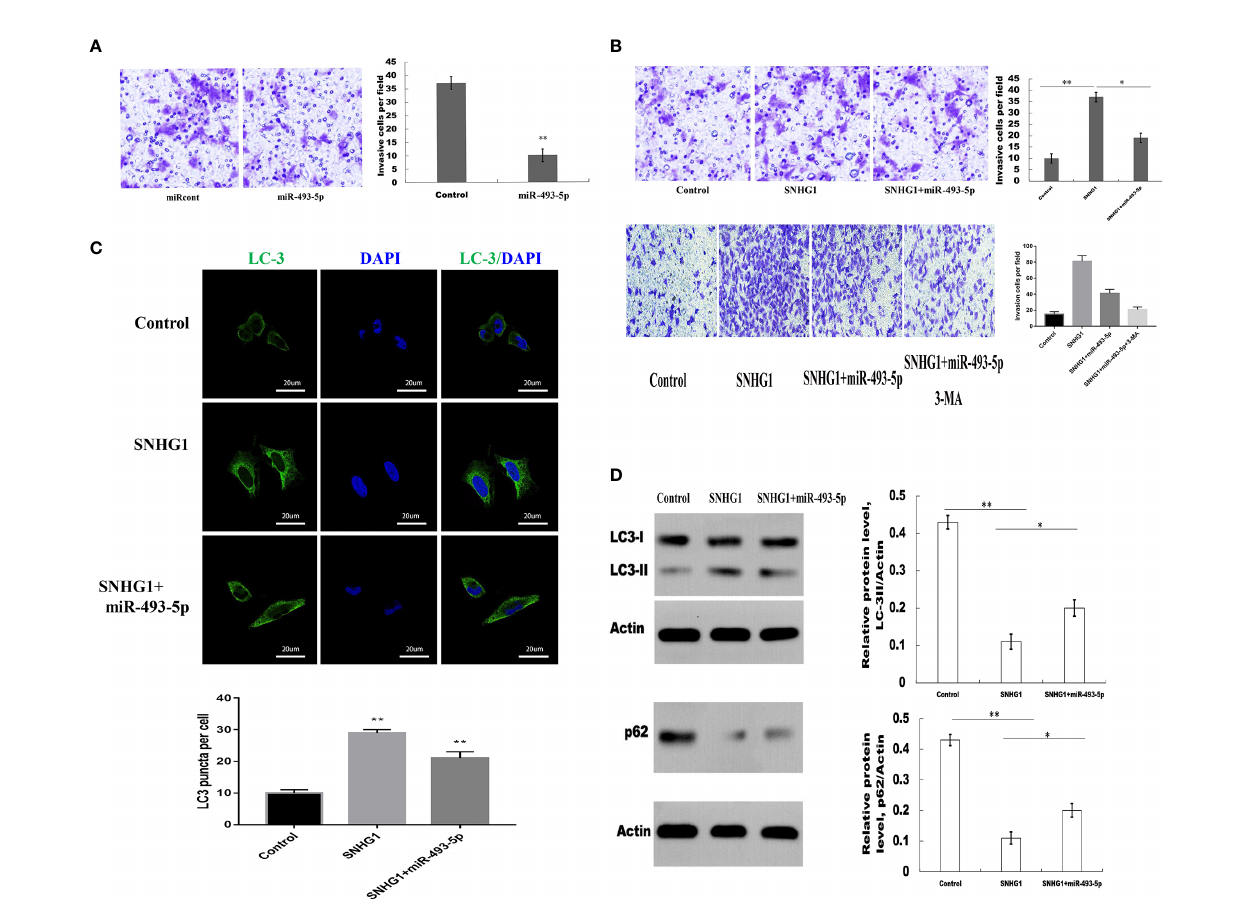
FIGURE 5 | miR-493-5p plays an important role in SNHG1 induced bladder cell invasion and autophagy. (A) T24 bladder cancer cells were cultured with miR-493- 5P mimics, cell invasion assay was used to evaluate the cell invasion ability of T24 bladder cancer cells. (B) T24 bladder cancer cells were cultured with SNHG1 and SNHG1 plus miR-493-5P mimics, cell invasion assay was used to evaluate cell invasion ability of T24 bladder cancer cells (UP); 24 bladder cancer cells were cultured with SNHG1 and SNHG1 plus miR-493-5P mimics with or without 3-MA, cell invasion assay was used to evaluate cell invasion ability of T24 bladder cancer cells (down) (C) T24 cells were cultured with overexpressed SNHG1 or control or SNHG1 plus miR-493-5P, Cyto-ID autophagy detection kit was used to evaluate cell autophagy. (D) T24 cells were cultured with overexpressed SNHG1 or control or SNHG1 plus miR-493-5P; western-blot was used to determine the protein expression levels of LC3I, LC3II and p62 (Data presented as mean ± SD, *p < 0.05, **p < 0.01 compared to the